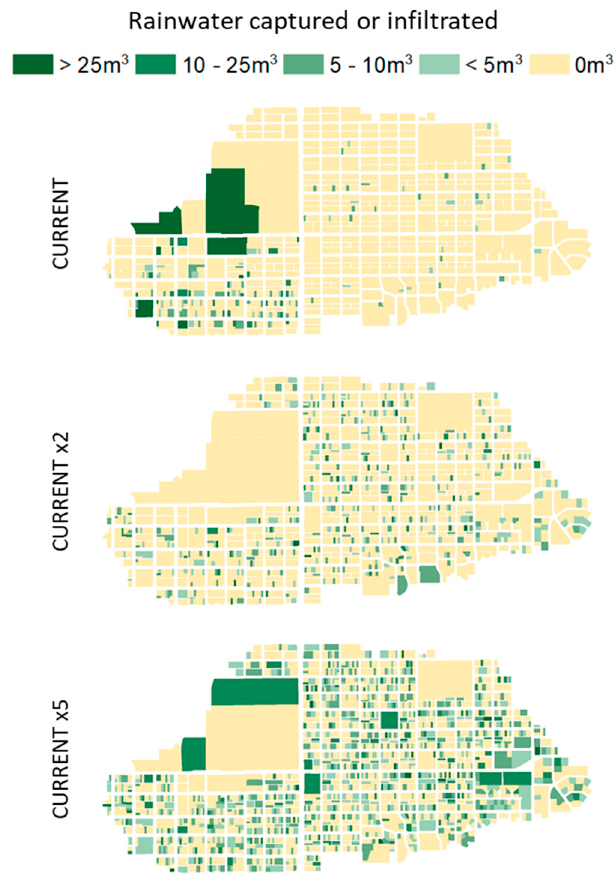
Figure 6. Spatial comparison of the volume of rainwater captured in cisterns or infiltrated in basins for configurations CURRENT ( top ), CURRENT × 2 ( middle ), and CURRENT × 5 ( bottom ) as compared to the NO GI configuration for the 25-year design storm event. RB: On-street basins. RRH: Roof runoff harvesting cistern.